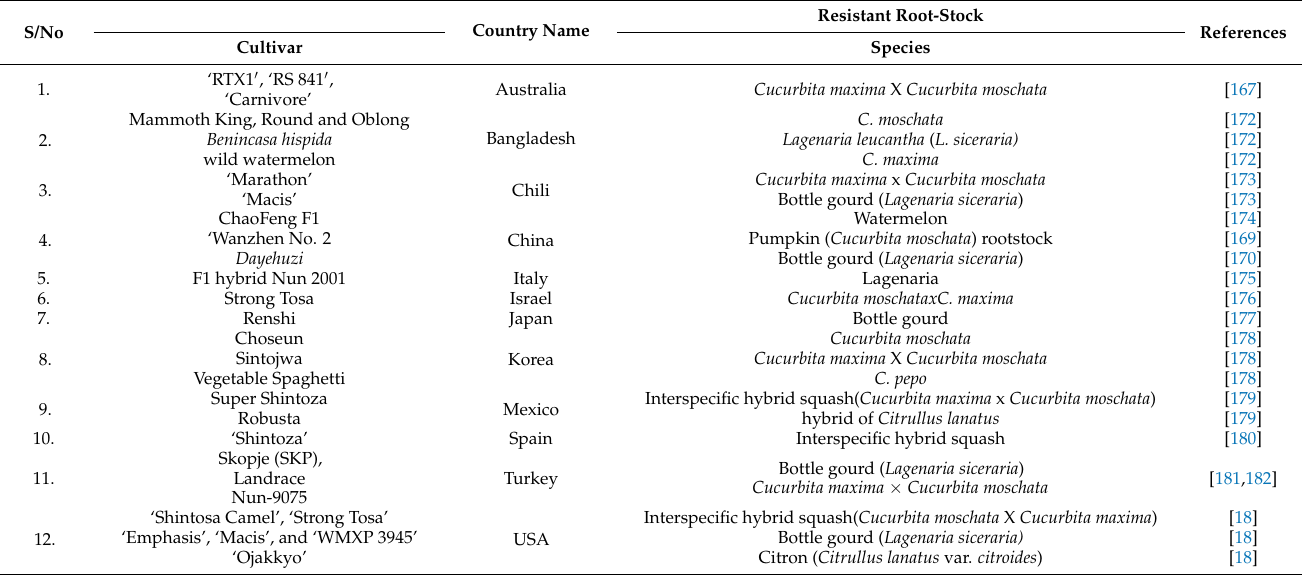
Table 5. The rootstock used for resistance to Fon in different